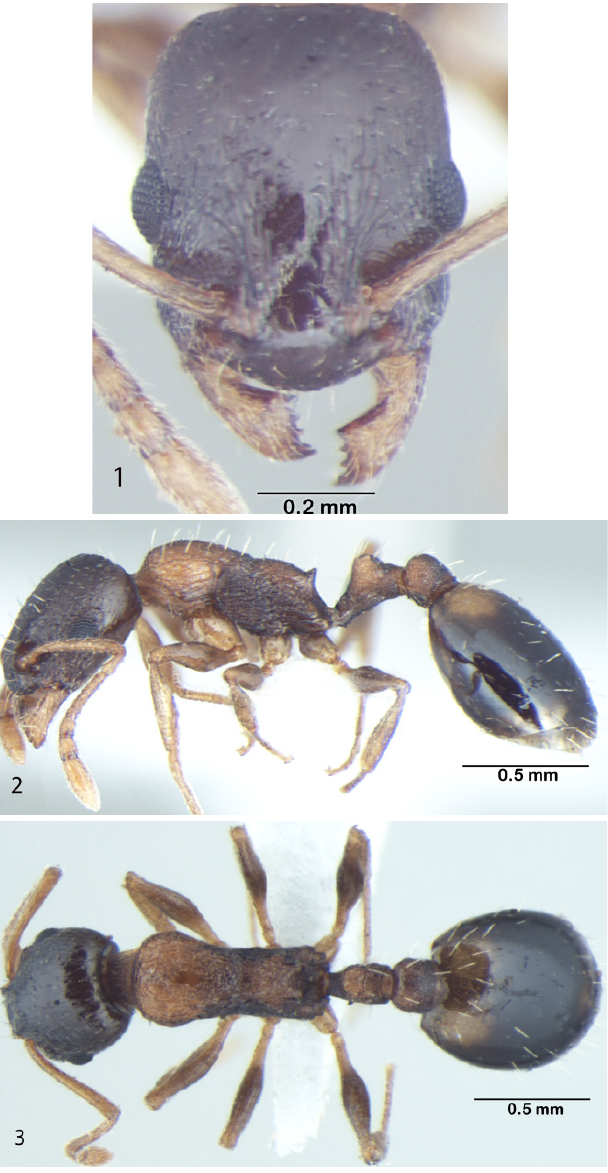
Figs 1-3 . Worker Temnothorax simlensis stat. nov.: 1- Head, full face view; 2- Body, lateral view; 3- Body, dorsal view